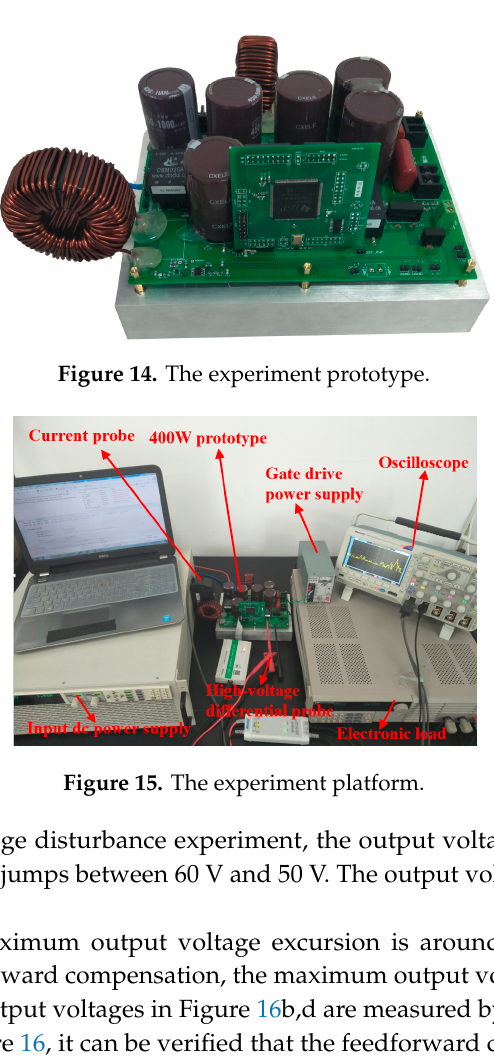
Figure 13. The duty cycle variation curve.